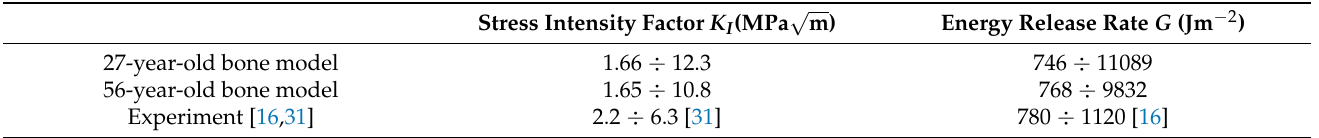
Table 3. Simulation and experiment values of K I and G .